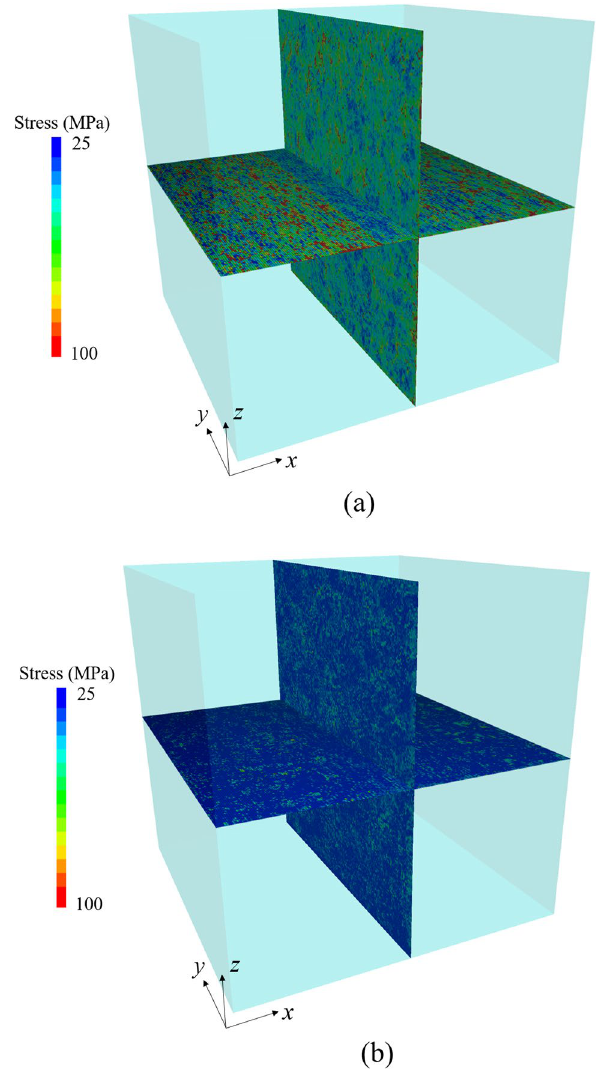
Fig. 7 Heterogeneous stress distribution within the fault damage zone: a Contour of the maximum compressive stress b Contour of the minimum compressive stress